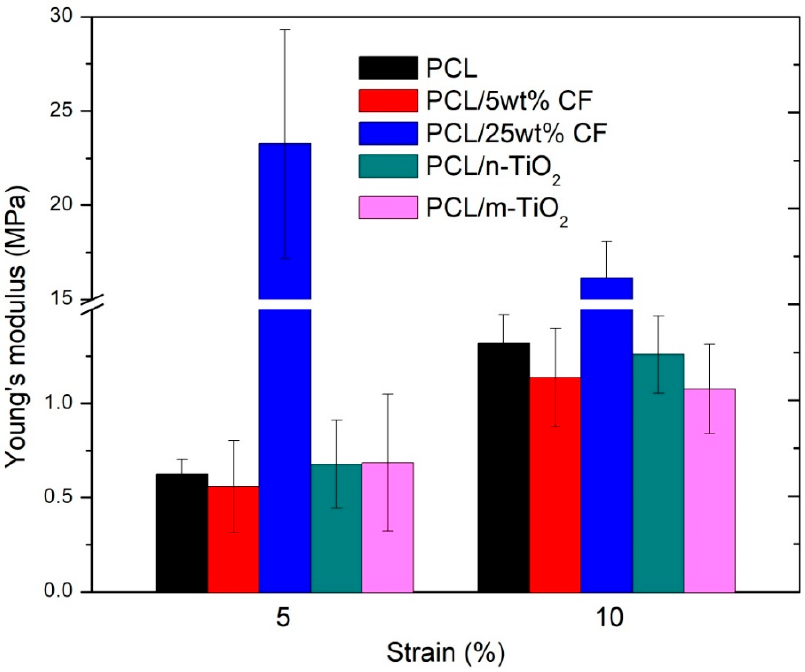
Figure 8. Young’s moduli of the electrospun scaffolds.